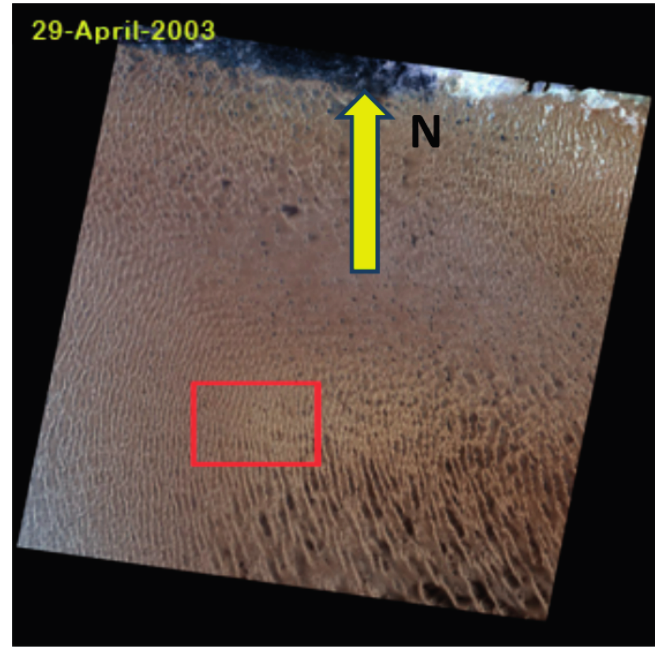
Figure 4. Landsat 7 ETM+ image over Libya 4. The red rectangle in the bottom images marks the chosen region of interest (ROI) with latitude (min and max): 28.45, 28.64, longitude (min and max): 23.29,